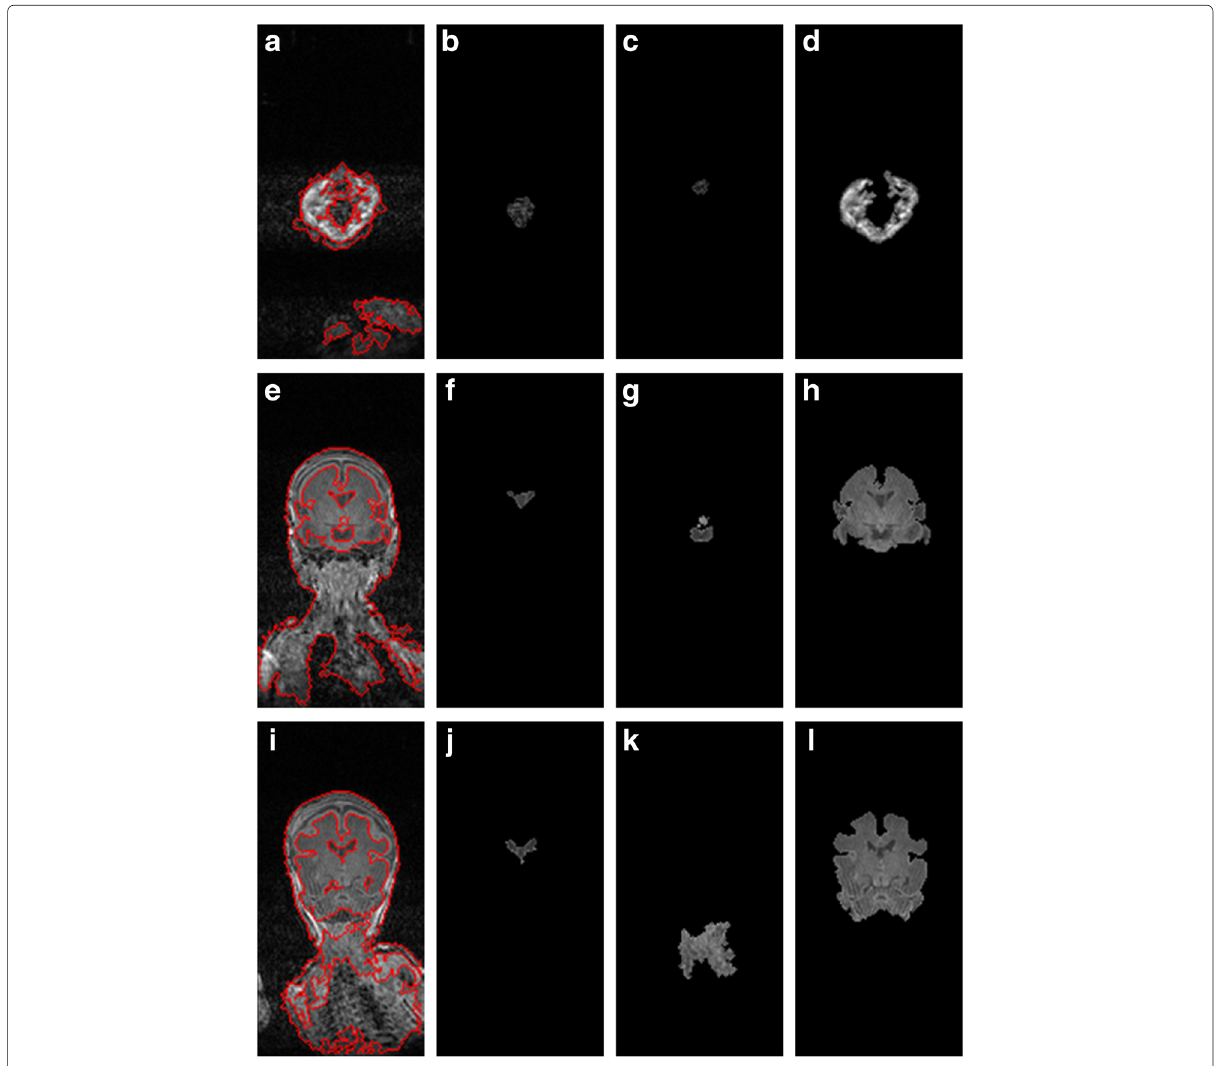
Fig. 6 Segmentation processes for the other frames: a the 14th MR image, b–d segmented parts, e the 50th MR image, f–h segmented parts, i the 67th MR image, and j–l segmented